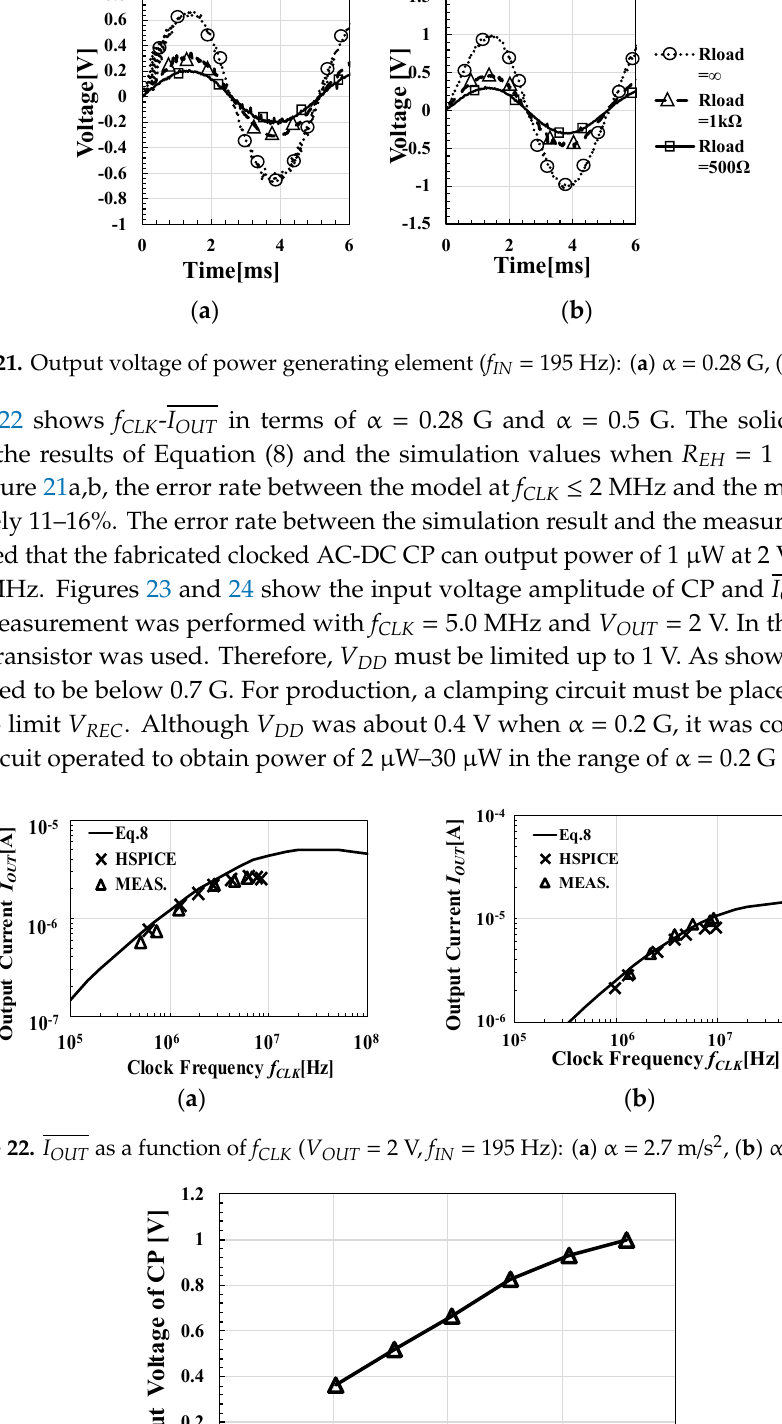
Figure 20. Measured V DD as a function of α ( R L = ∞ , f IN = 195 Hz).